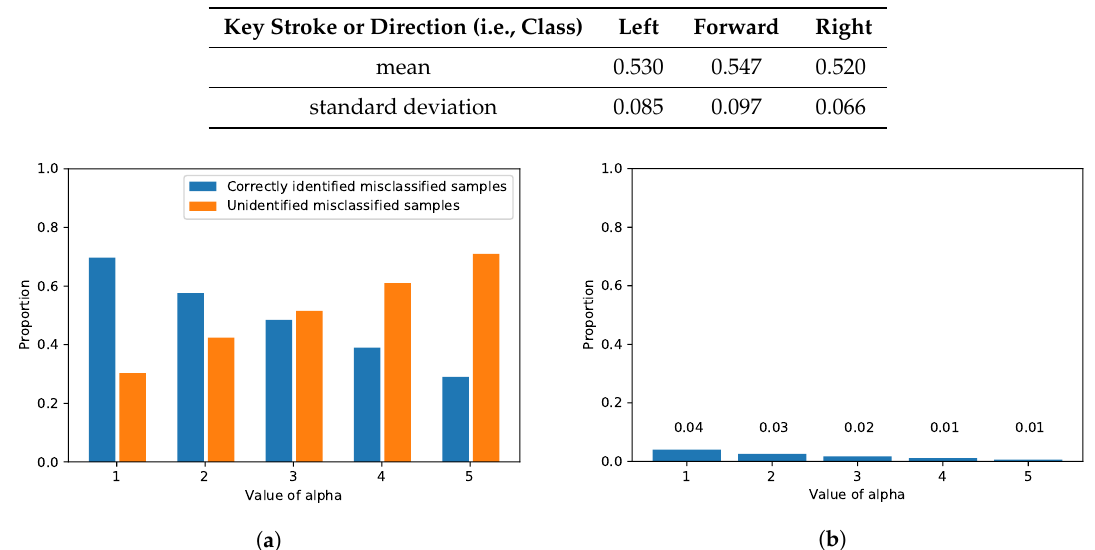
Table 3. Per-class means and standard deviations of the max2 uncertainty score acquired from feeding the validation dataset to the trained model.